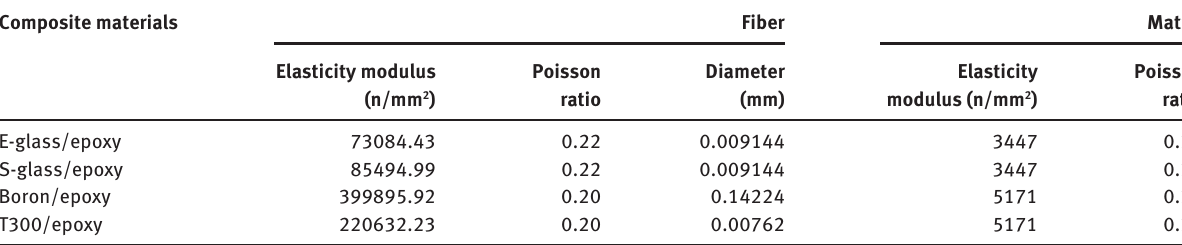
Table 1 Composite samples.